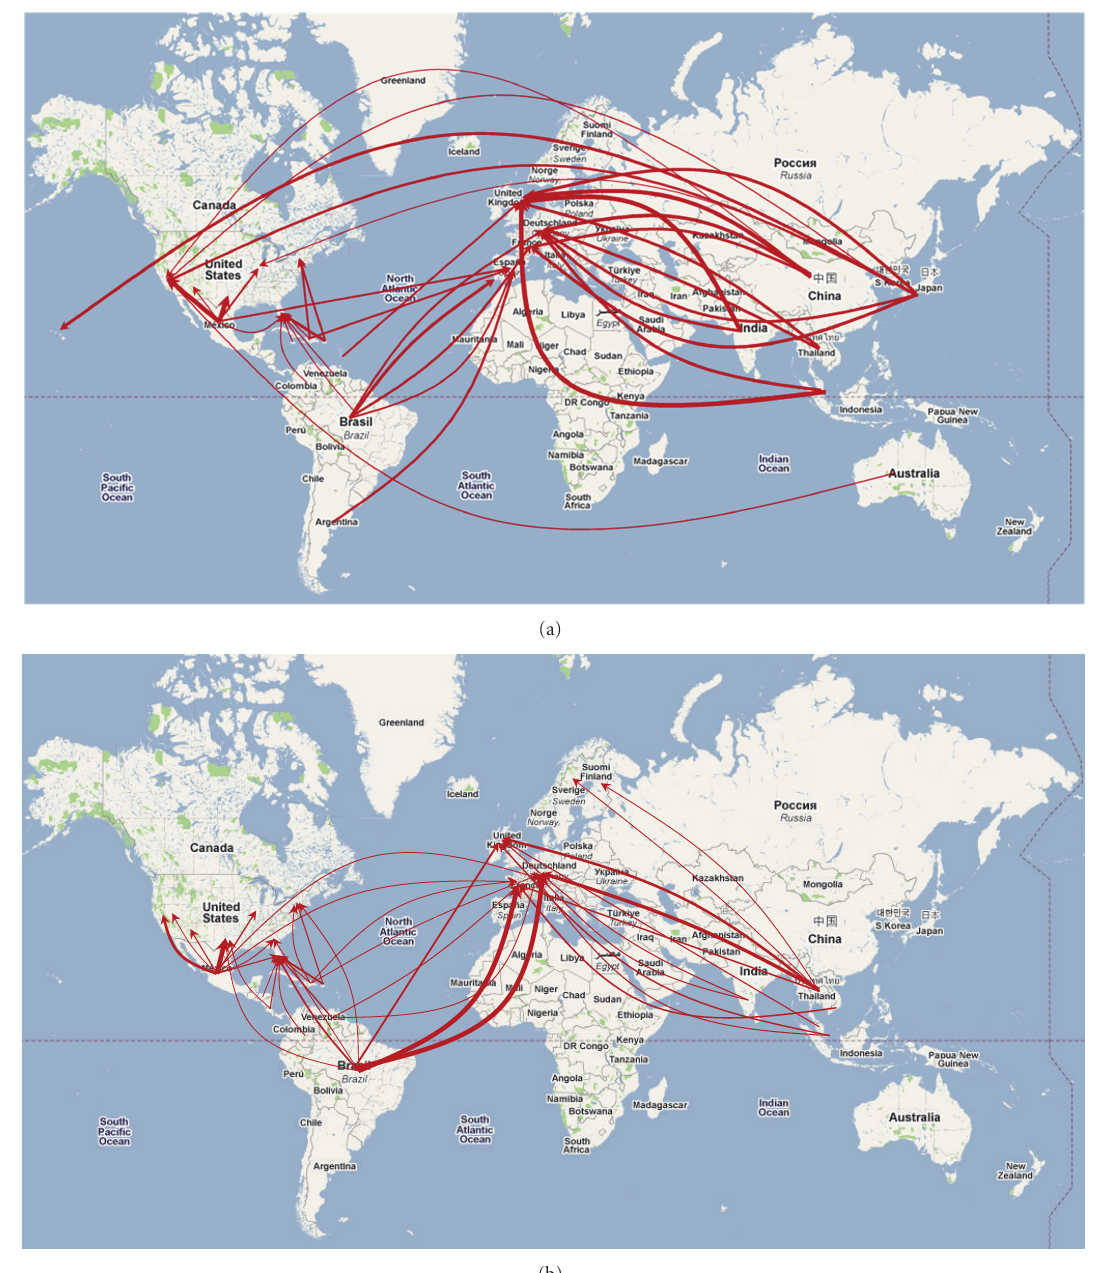
Figure 2: (a) The 20 highest traveled routes entering the U.S. and E.U. There are 40 total links; the line thickness is proportional to the travel volume. (b) The top 20 travel routes with highest relative risk of carrying Dengue infected passengers into U.S. and E.U. The line thickness is proportional to the relative risk of the